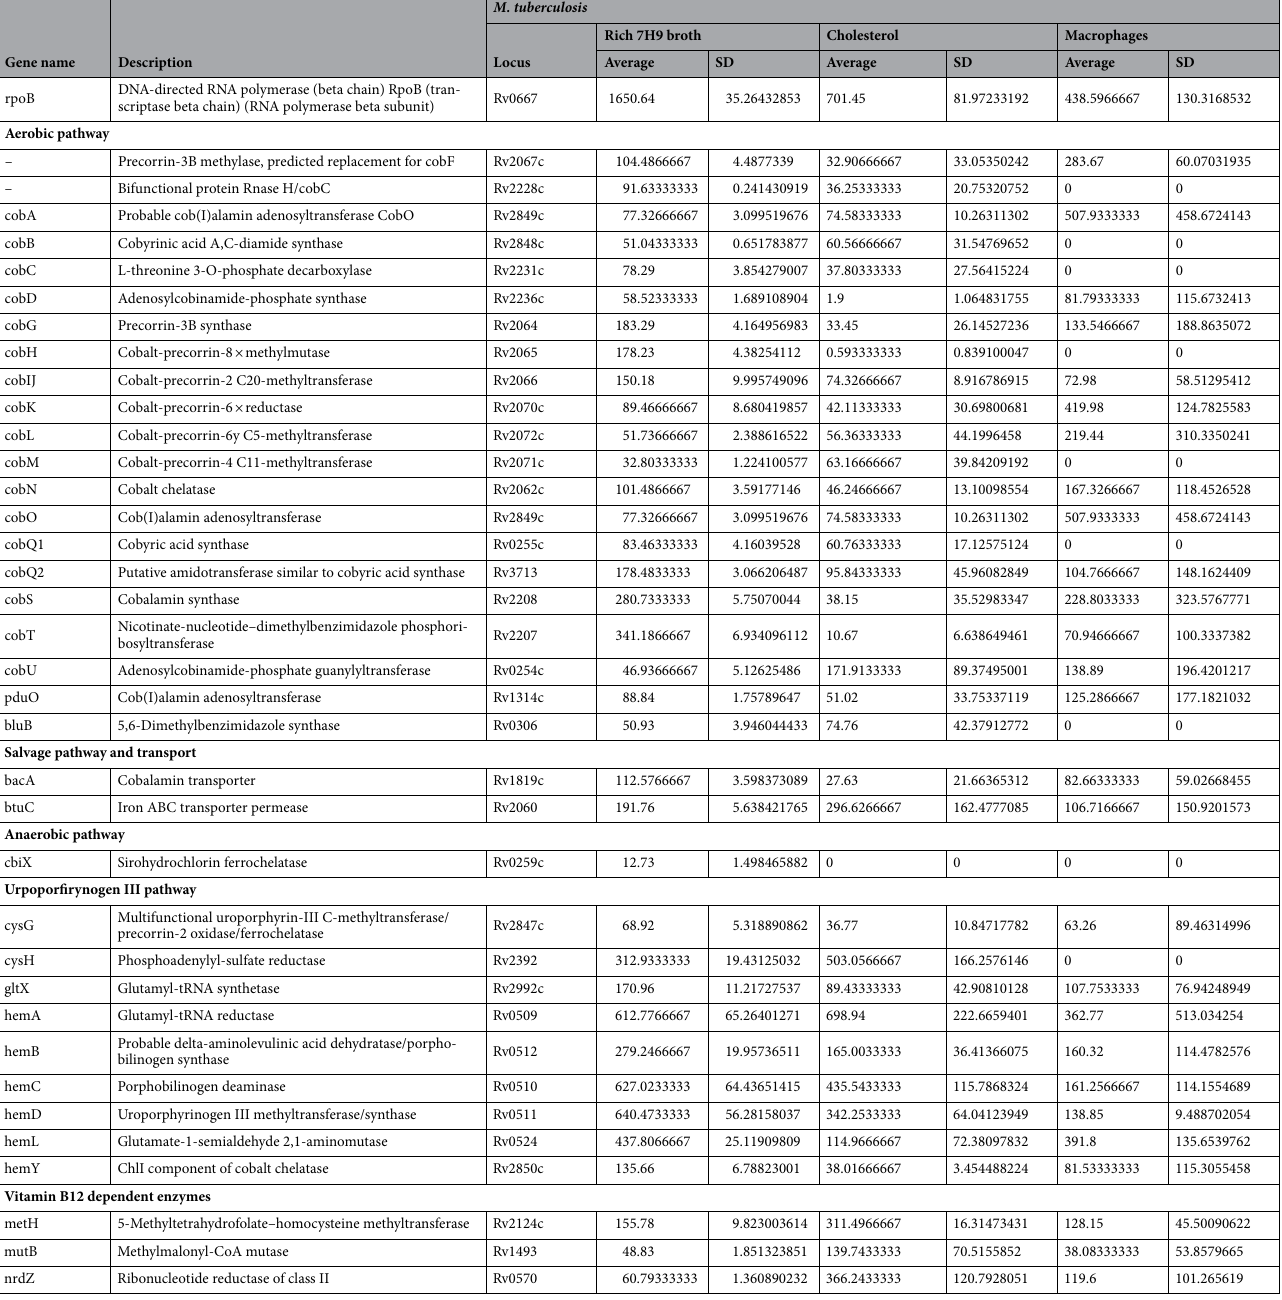
Table 2. Expression of genes involved in cobalamin metabolism in M. tuberculosis H37Rv based on RNA-Seq